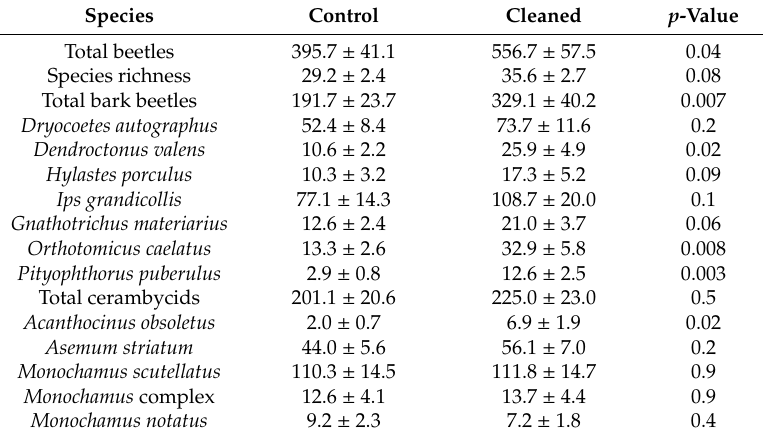
Table 2. Mean (±SE) total beetles, species richness, total bark beetles, total cerambycids, and individual species that accounted for ≥1% of total beetles captured in trap treatments during Experiment 2.